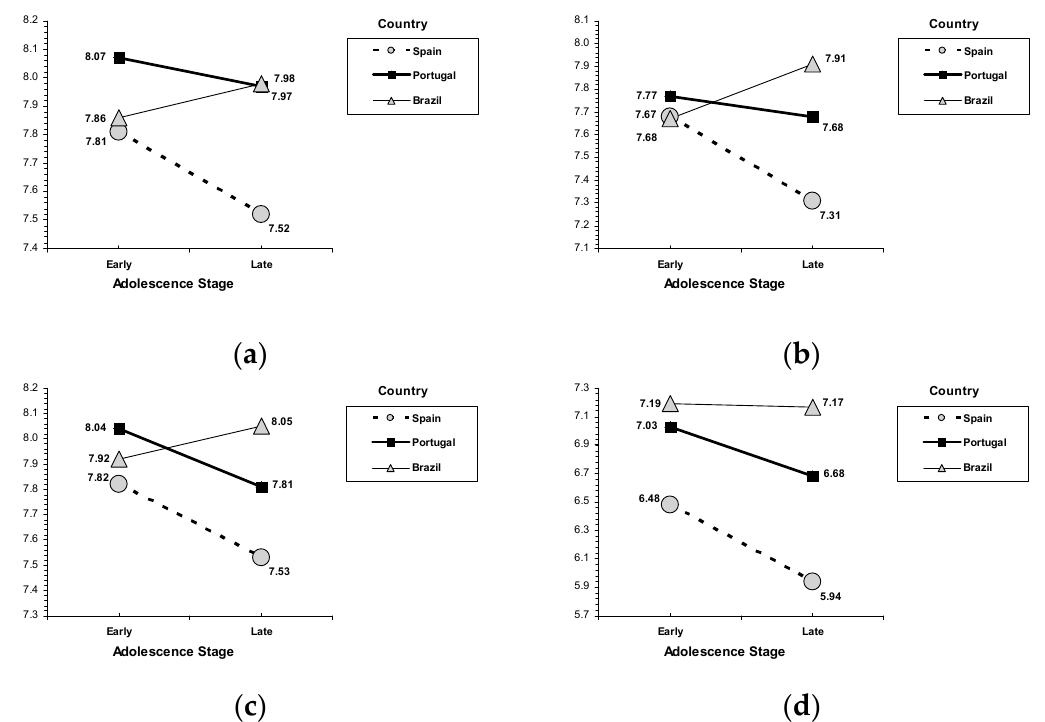
Figure 3. Interactions for adolescent stage and country. ( a ) universalism, ( b ) security, ( c ) conformity, ( d ) tradition.